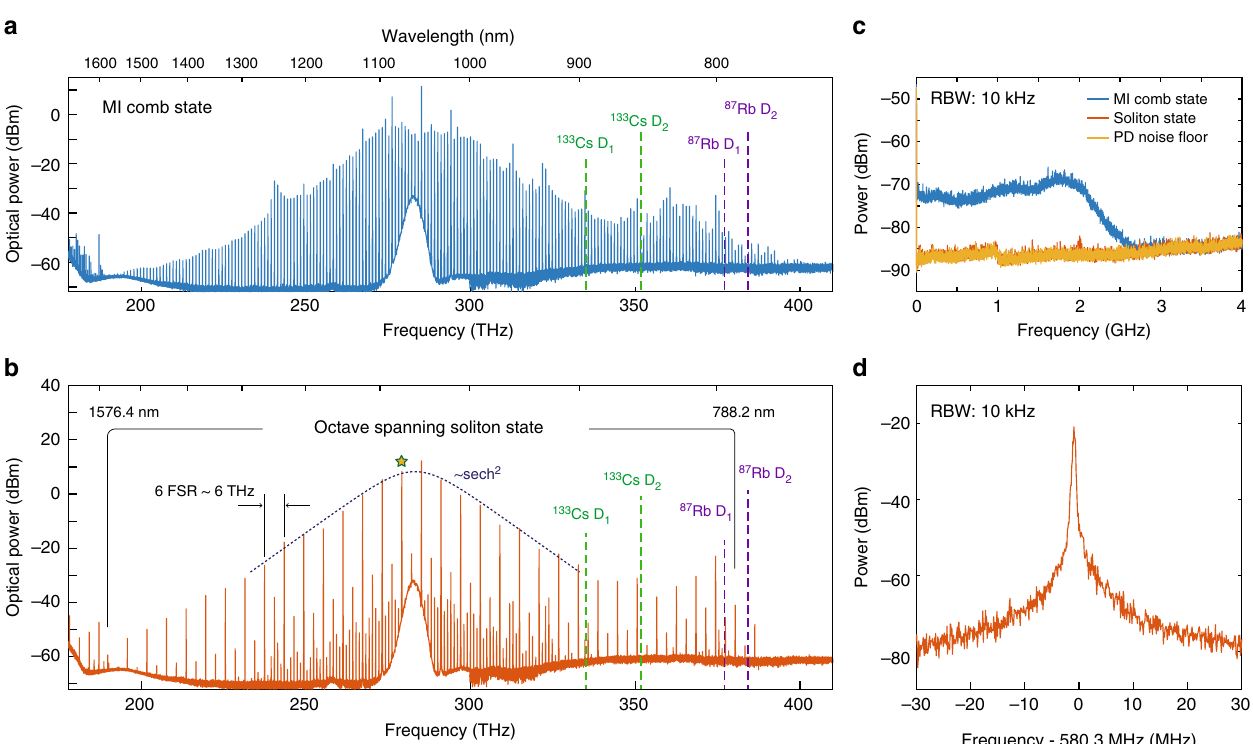
Fig. 3 Octave-spanning microresonator-based dissipative Kerr soliton state in the biological imaging window. a Spectrum of a noisy Kerr comb state obtained with ~800 mW on-chip power (pump is located at around 1051.5 nm), from the microresonator with optimised dispersion for octave-spanning operation. Green and purple dashed vertical lines indicate the spectral locations of Cs and Rb optical atomic transitions. b Spectrum of the octave-spanning soliton state obtained in the same microresonator. The spectrum is fi tted with sech 2 envelope (dashed dark blue), from which a soliton duration of 17 fs is inferred. The set of enhanced lines below 190 THz corresponds to the second diffraction order of optical spectrum analyser diffraction grating, and are thus artefacts. c Intensity noise of the octave-spanning MI comb state (blue) and soliton state (red) shown in ( a ). Yellow trace shows the noise fl oor of the photodetector used for measurements. d Heterodyne beatnote of the soliton comb line (marked with a star in panel ( b )) with a second CW